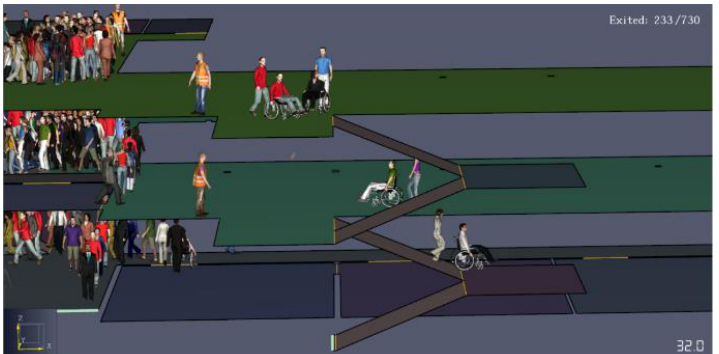
Figure 9. Evacuation situation diagram of external ramp.